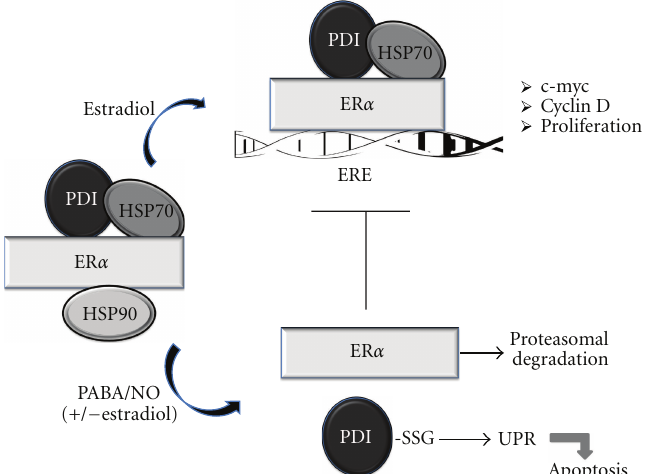
Figure 1: Model of the chaperone activity of PDI with ER α . S-Glutathionylation of PDI can interfere with protein folding, prevent protein interaction with ER α , and plausibly destabilize the receptor and subsequent ER α